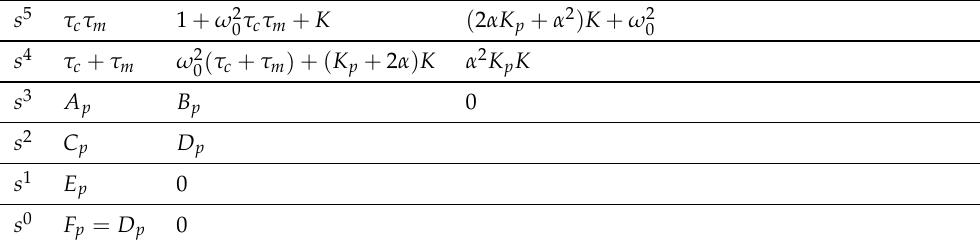
Table 2. Routh table for the position-control